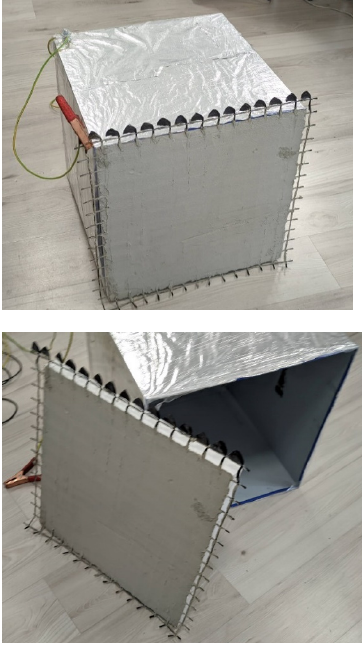
Figure 3. The box used for electromagnetic tests.